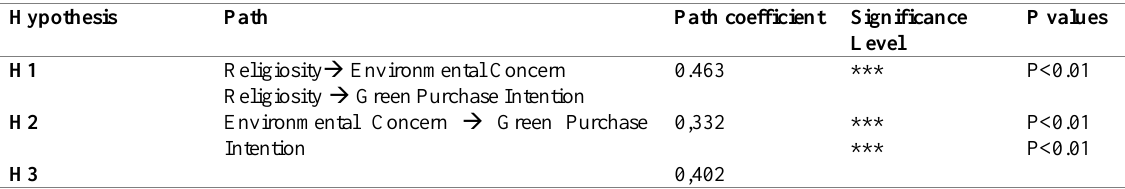
Table 3: Significance Testing Result of the Structural Model Path Coefficient